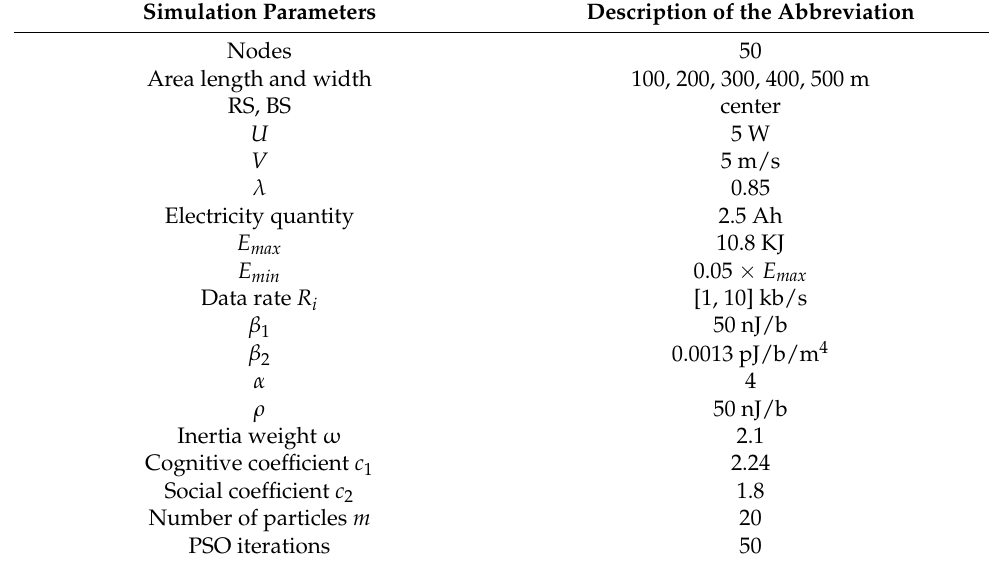
Table 1. Parameters used.